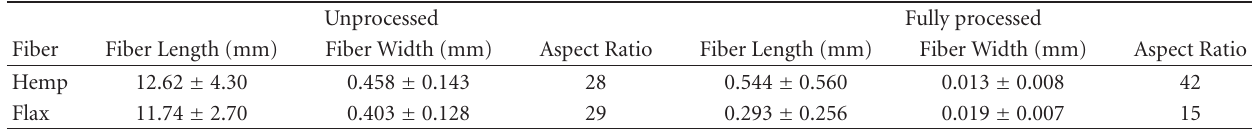
Table 3: Mean lengths, widths, standard deviations, and aspect ratios of unprocessed and fully processed hemp and flax fibers extracted from composites with fiber content of 40 wt% and plasticizer content of 32.5wt%.